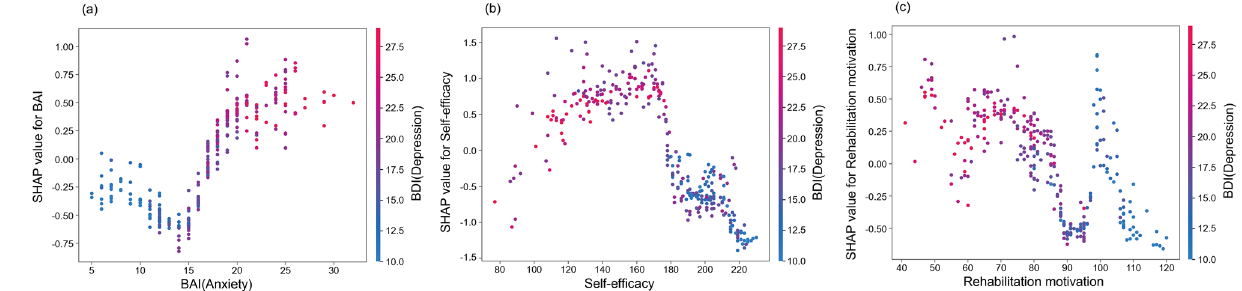
Figure 3. Partial dependence plot by SHAP value. Relationship between ( a ) self-efficacy and depression ( b ) rehabilitation motivation and depression ( c ) anxiety and